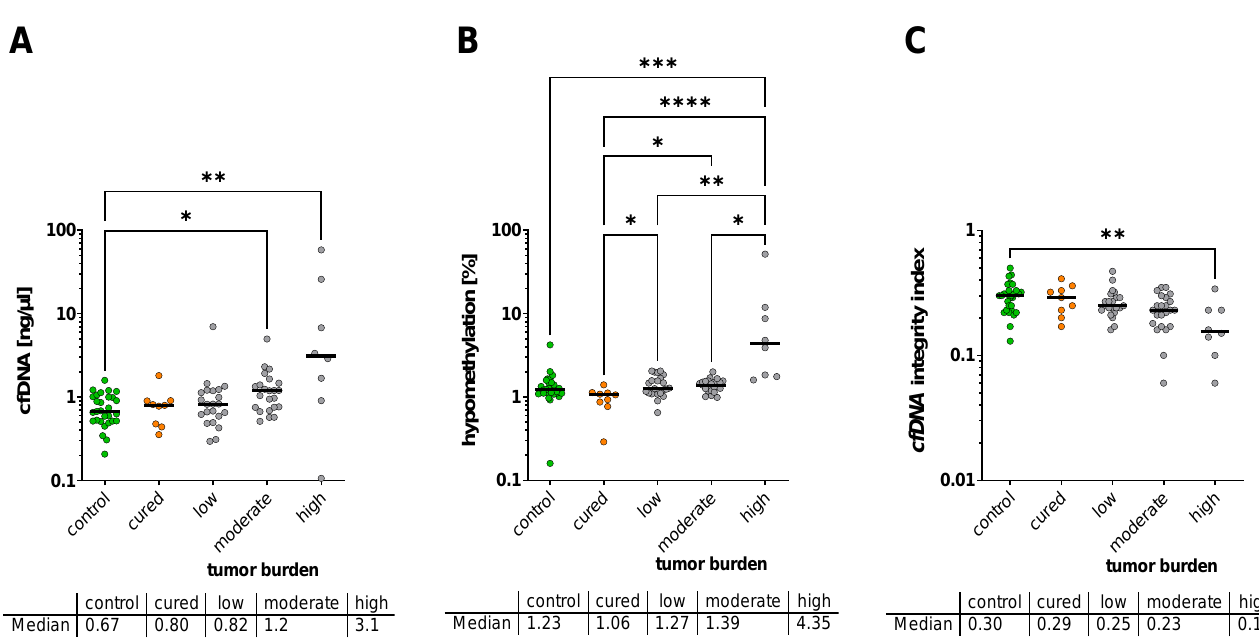
Figure 2. Plasma cfDNA concentration ( A ), cfDNA hypomethylation ( B ), and cfDNA integrity ( C ) with respect to tumor burden (no tumor, low, moderate, or high tumor burden) * p < 0.05.; ** p < 0.01; *** p < 0.001; **** p < 0.0001.